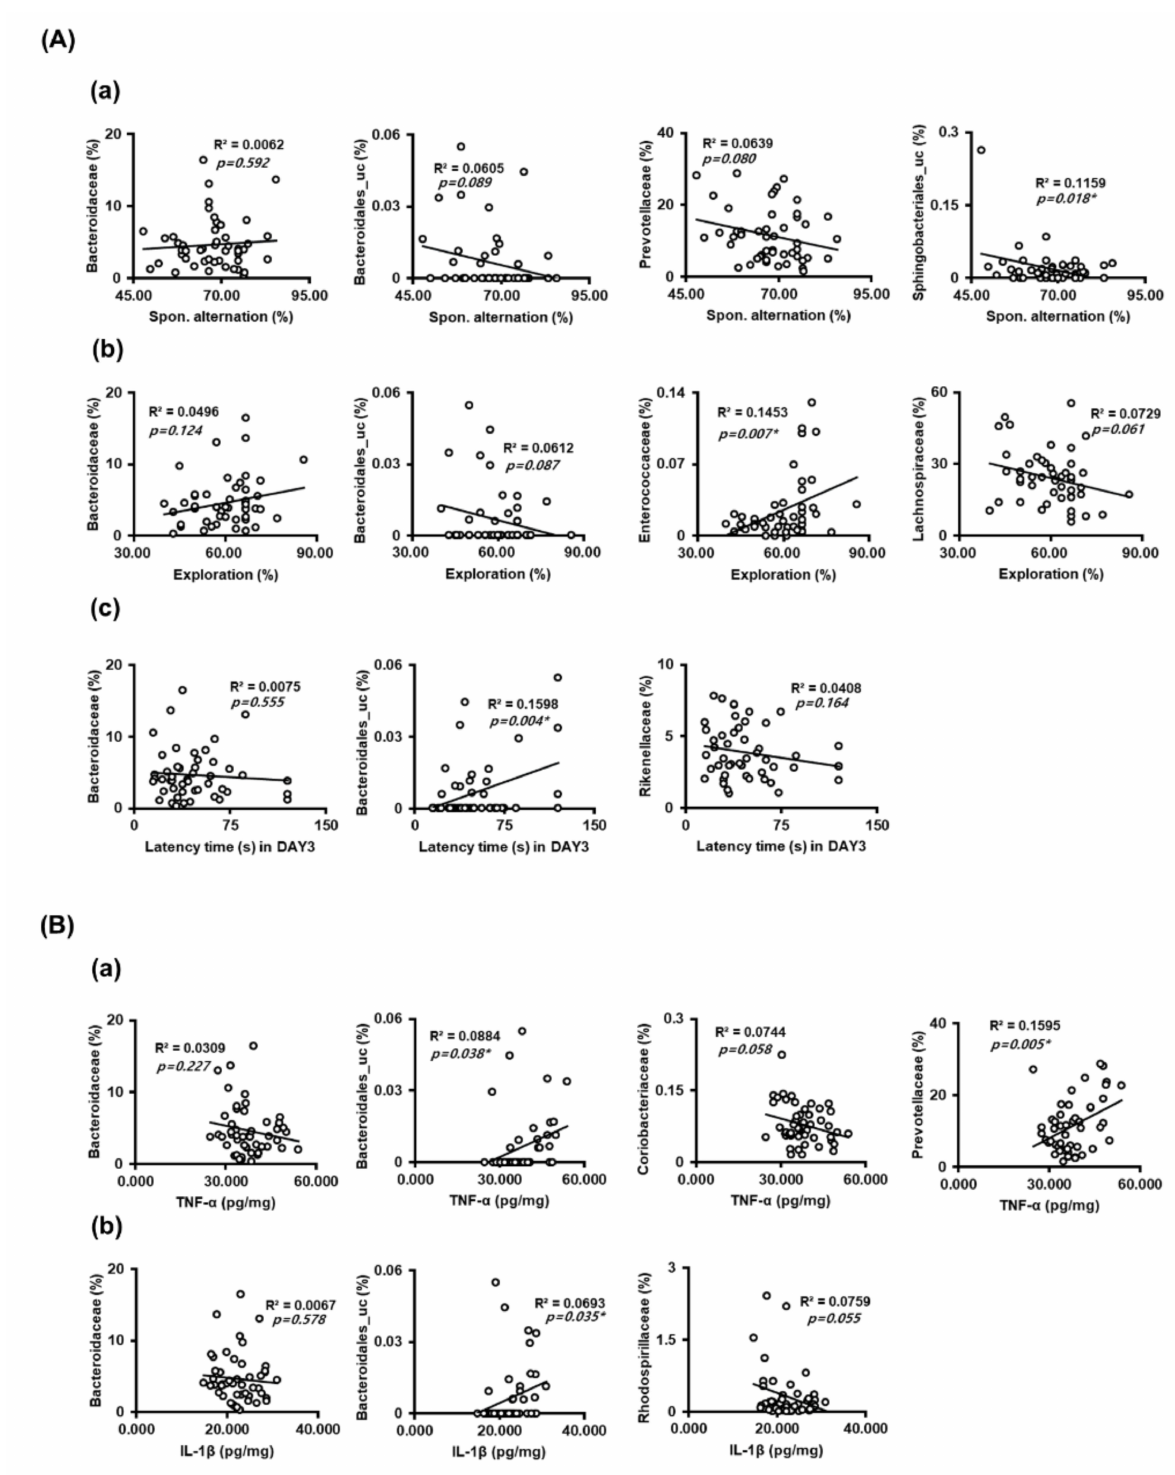
Figure 5. The correlation between the gut microbiota populations and cognitive function or hippocampal proinflammatory cytokines. ( A ) The correlation between the gut microbiota populations and cognitive function in the Y-maze ( a ), novel object recognition apparatus ( b ), and Barnes maze ( c ). ( B ) The correlation between the gut microbiota populations and proinflammatory cytoknes TNF- α ( a ) and IL-1 β ( b